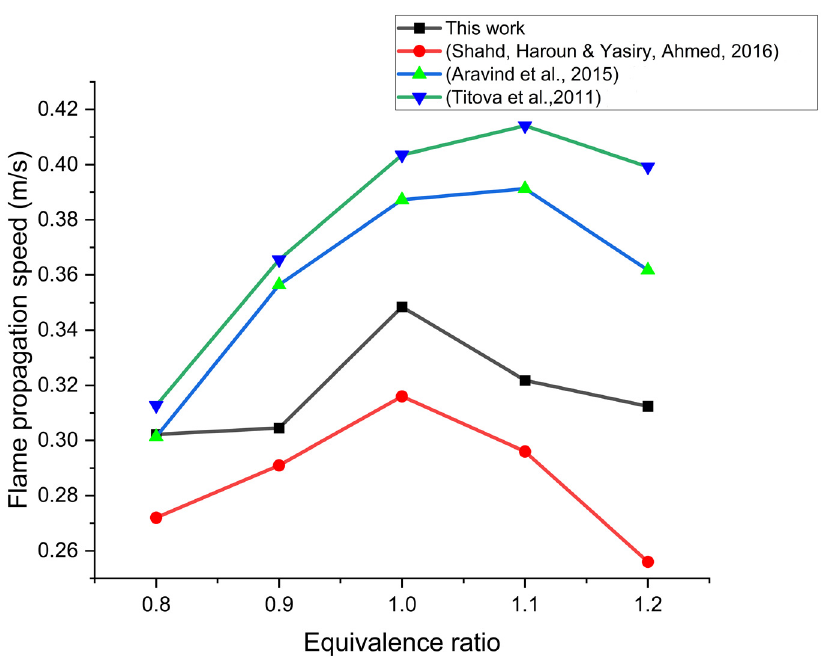
Figure 5. The calibration of flame propagation speed compared to other LPG experiments [25–27].